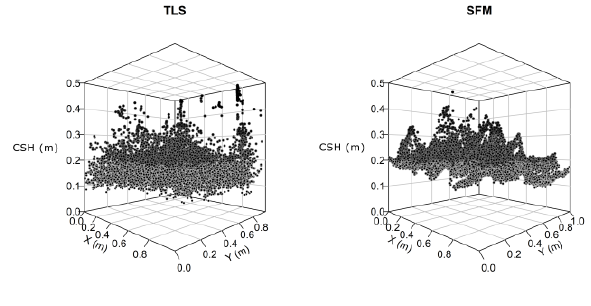
Figure 1: Comparison of point cloud density and penetration depth of TLS (left) and SfM (right) approaches